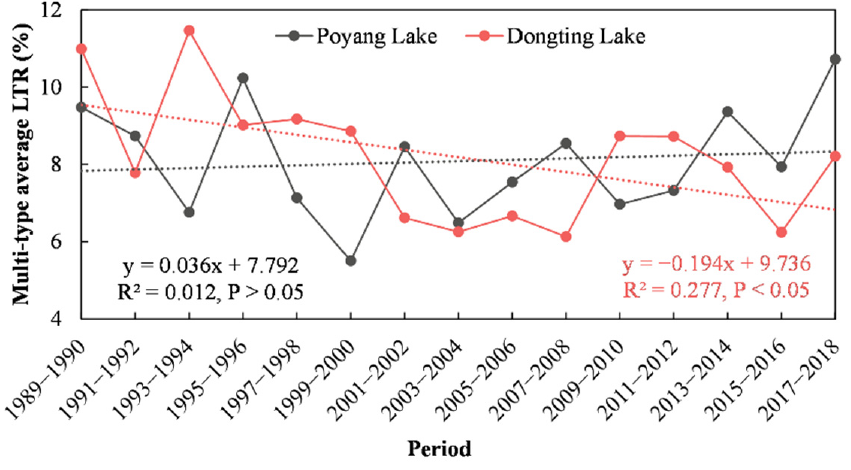
Figure 6. Time series of multi-type average LTR in Poyang Lake and Dongting Lake from 1989 to 2020.